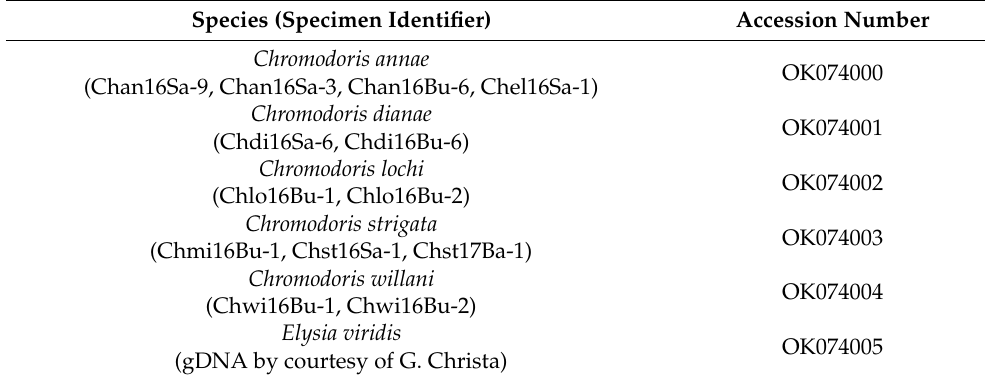
Table 2. Specimens used for designing primers of the putative actin gene fragment and accession numbers of the obtained consensus sequences of the five Chromodoris species and the Elysia viridis